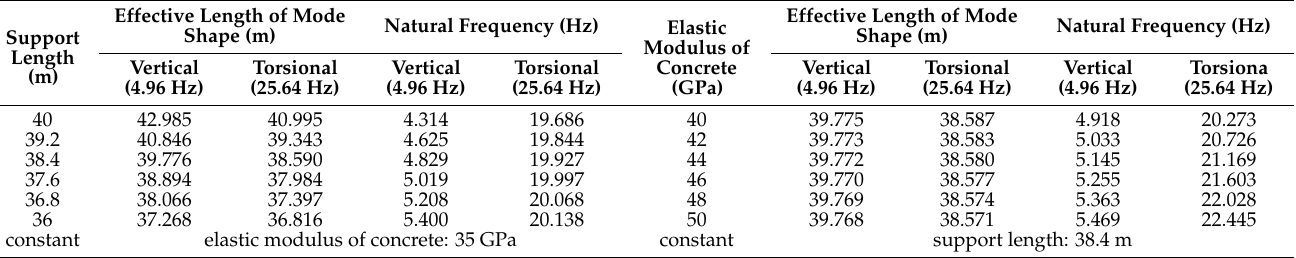
Table 4. Sensitivity analysis results for the numerical model of the Imgi 2nd Bridge.